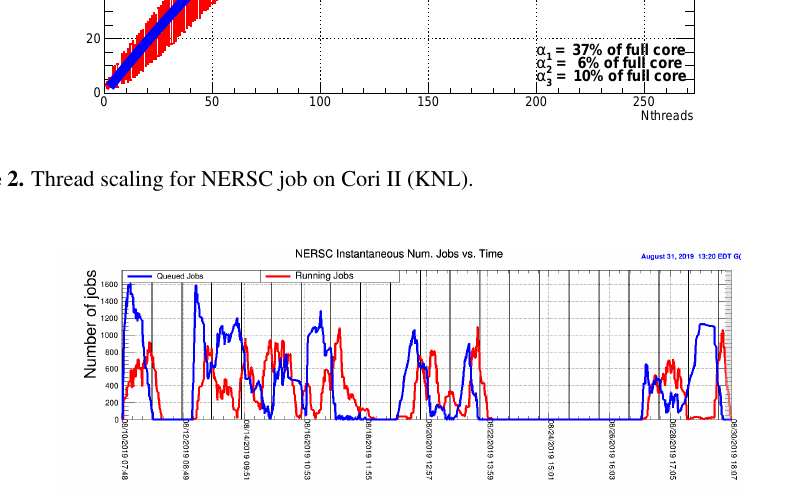
Figure 3. RunPeriod2018-08 data processing at NERSC for batch 01 using the “regular” priority queue. The red curve shows the instantaneous number of running jobs while the blue shows the number of jobs queued, but not yet